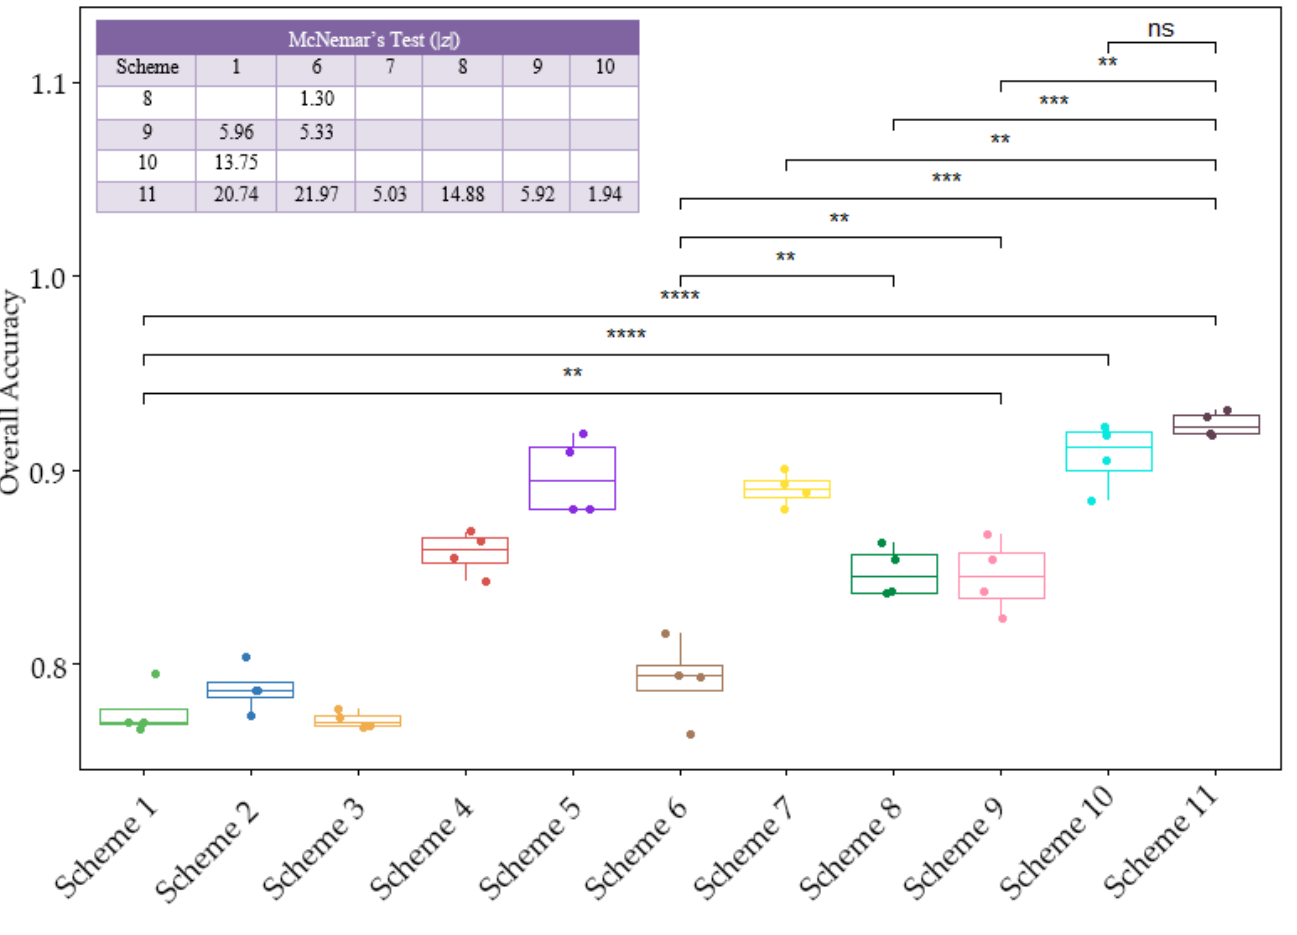
Figure 6. Statistical boxplots of overall accuracy for eleven classification schemes using four models. Different number of ‘*’ represents the significant difference of classification schemes at different confidence levels in the t -test. ns: p > 0.05**: p ≤ 0.01; ***: p ≤ 0.001; ****: p ≤ 0.0001. McNemar test: the difference in classification results was significant at the 95% confidence level when |z| > 1.96. Table 9. Improvement of average accuracy (half of the user accuracy and producer accuracy) for different marsh vegetation when kinds of variables introduced by multi-source